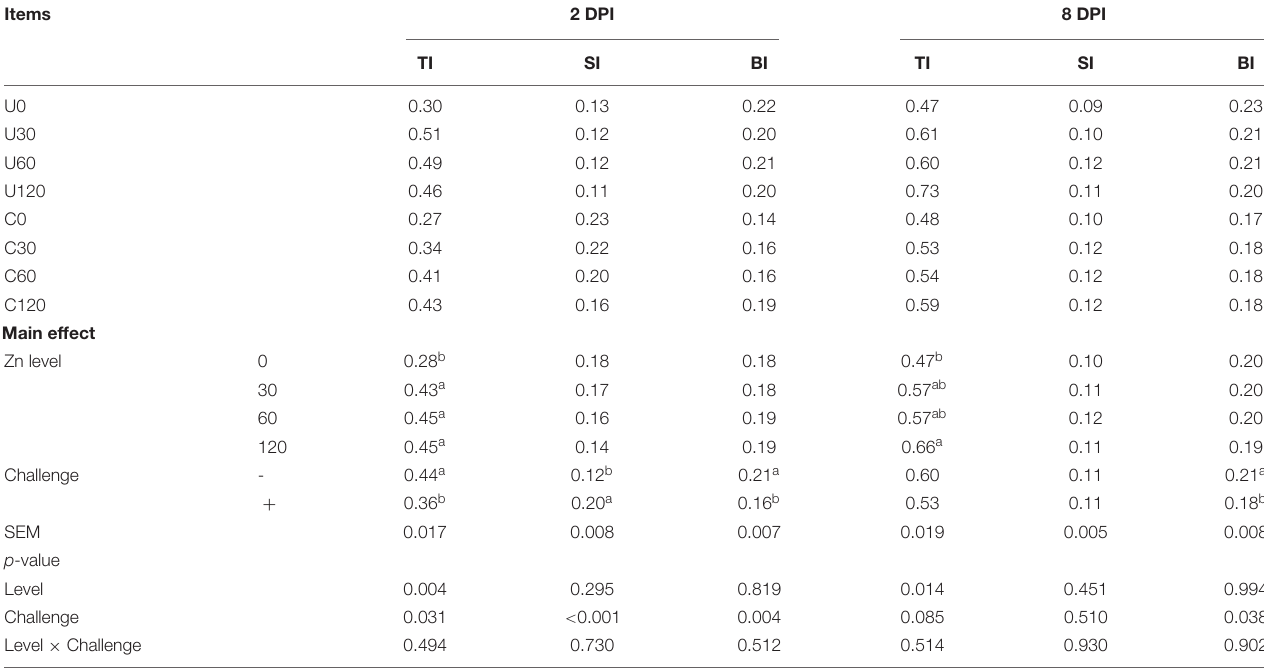
TABLE 6 | Effect of dietary Zn–Met levels on the relative weight of immune organs of meat duck challenged with APEC (%) 1 . Items